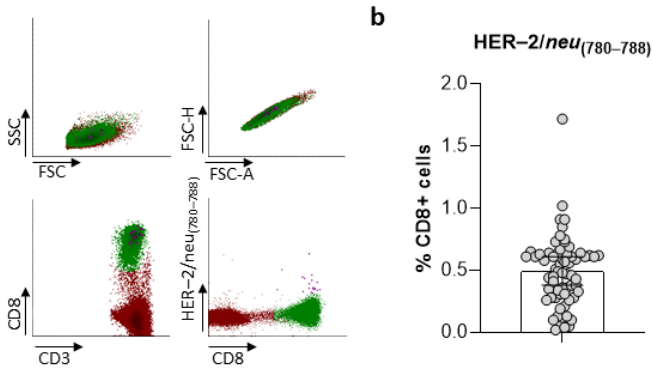
Figure 1. ( a ) The flow cytometry gating strategy used to analyze HLA-A*24:02-HER-2/ neu (780–788) - specific CD8+ T lymphocytes identified by multiparameter flow cytometry following incubation with the MHC dextramer HLA-A*24:02+ HER-2/ neu (780–788) (PYVSRLLGI). Forward versus side scatter (FSC vs. SSC) gating was used for the identification of lymphocytes, and FSC height (FSC-H) by FSC area (FSC-A) was used for discrimination of the doublets. Then CD8+ cells were gated and the specific CD8+ cells were identified. ( b ) Densities of HLA-A*24:02-HER-2/ neu (780–788) -specific T lymphocytes within the CD8+ cell subset. The results are presented as the median value with the 95% confidence interval